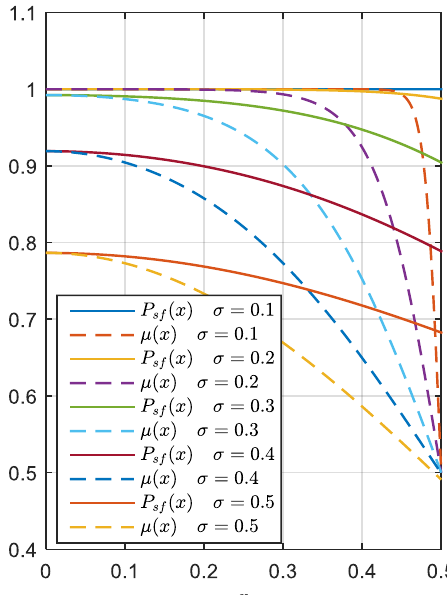
Figure 4. Illustration of the likelihood ratio threshold µ against the success fix rate P sf in the one-dimensional case.